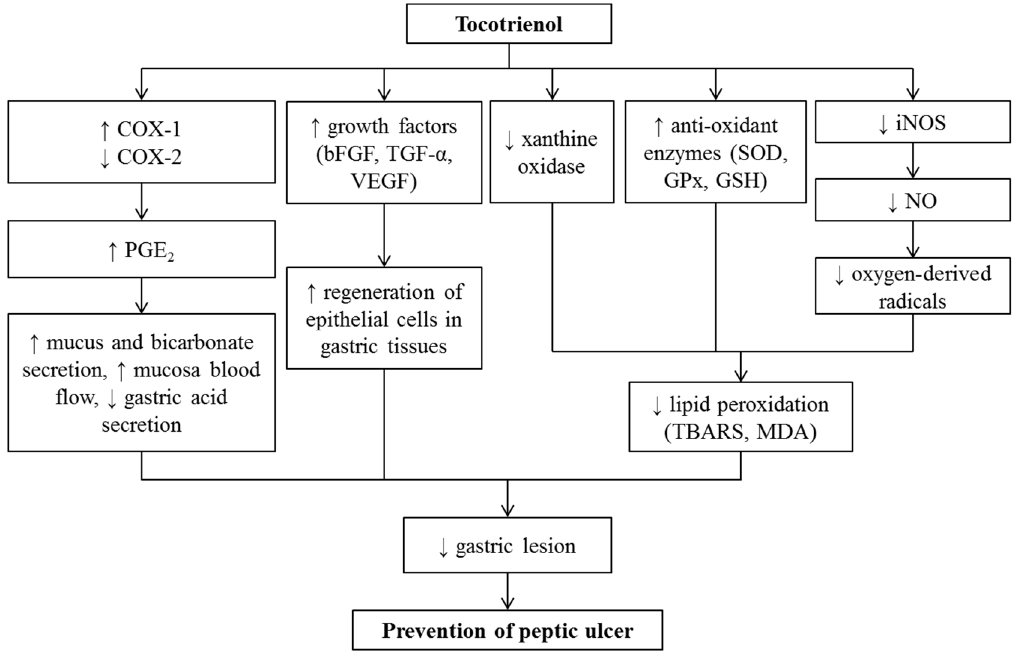
Figure 6. Effects of T3 on peptic ulcer. Figure 6. E ff ects of T3 on peptic